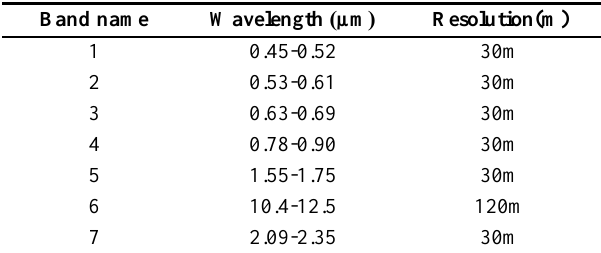
Table 1. TM Spectral Bands